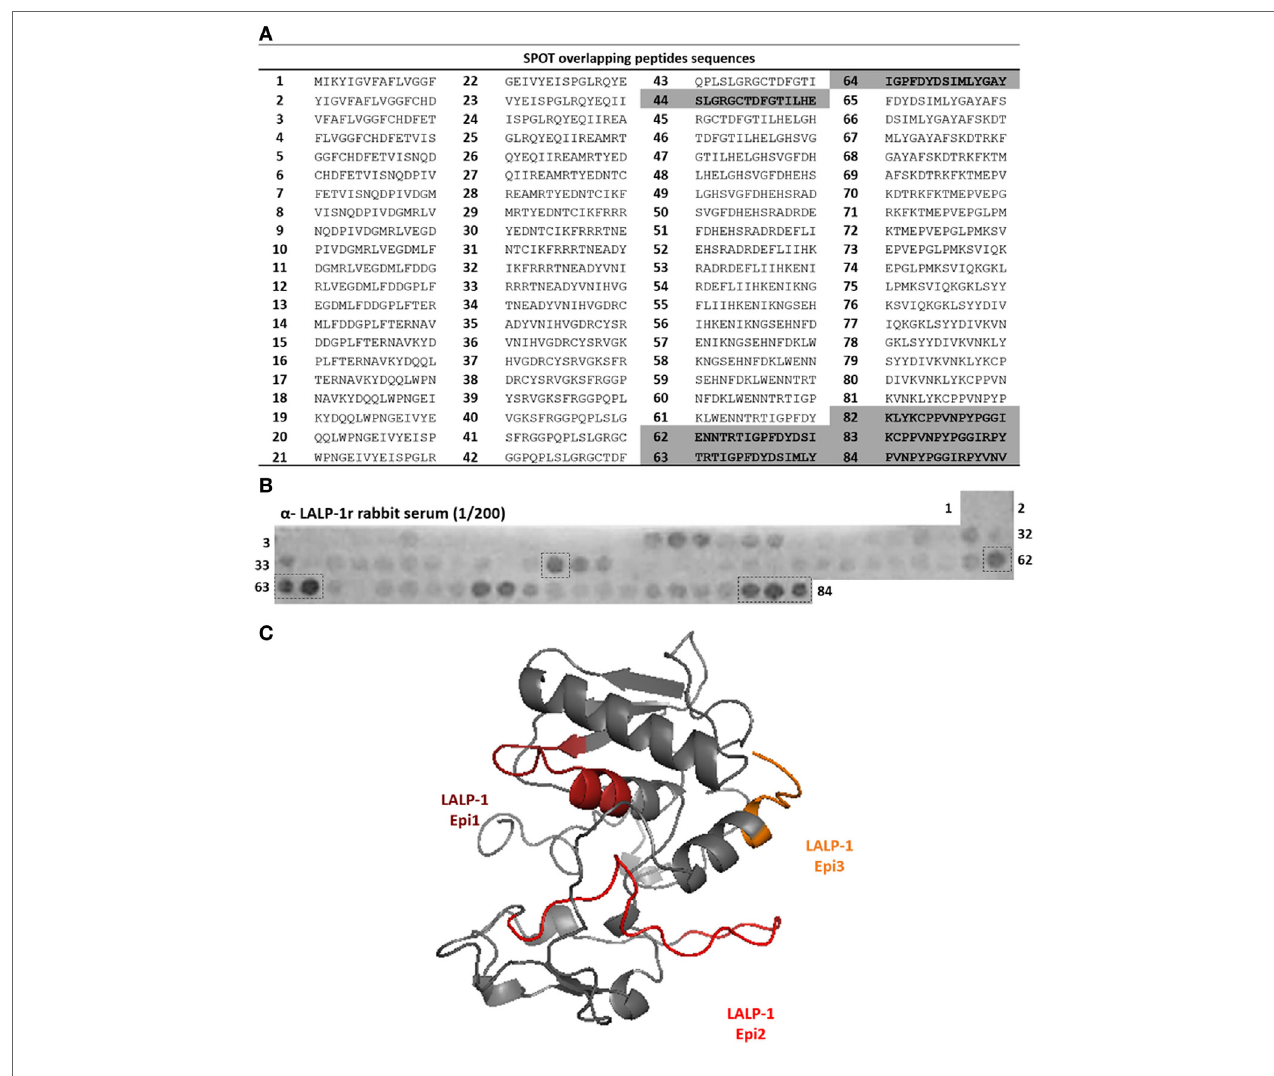
FigUre 1 | Epitope mapping of LALP-1 by SPOT method. (a) List of peptides sequences derived from LALP-1 sequence synthetized bound to the membrane, according to spot number. Sequences of most reactive spots are highlighted in gray. (B) Cellulose membrane containing bound 15-mer overlapping peptides derived from LALP-1 sequence, probed with anti-rLALP-1 rabbit serum, diluted 1/200. After incubation with secondary anti-rabbit-alkaline phosphatase antibody, MTT-BCIP substrate was added, revealing reactive spots in the membrane. Spots of higher intensity measured by ImageJ software are marked by a dotted line. (c) Homology model of LALP-1, generated by the I-TASSER server (34), using bone morphogenetic protein 1 protease domain, from Homo sapiens (PDB: 3EDH) as template. The epitope sequences mapped in the membrane are marked in orange, red andburgundy in the modeled